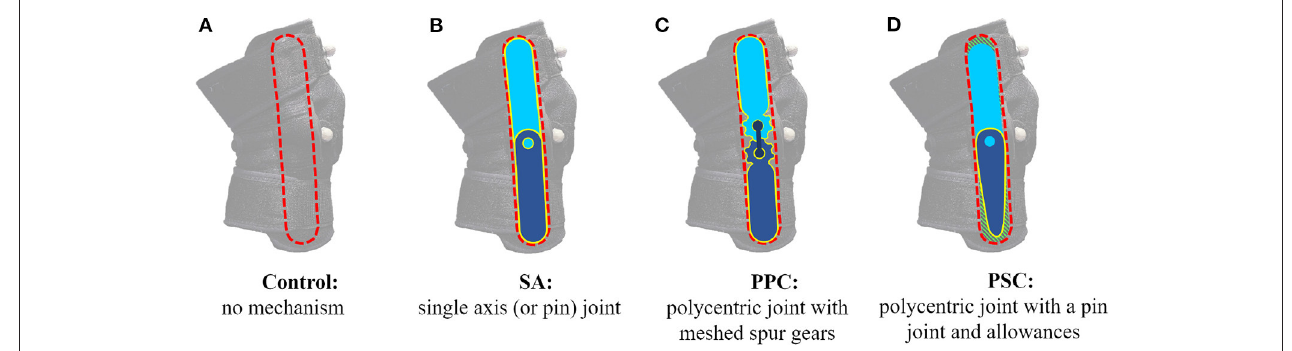
FIGURE 1 | Knee brace mechanisms: (A) Control brace with no mechanism, (B) single axis (SA) brace with a single axis mechanism, (C) polycentric mechanism with a predefined centrode (PPC) brace with a polycentric mechanism having spur gears, and (D) polycentric mechanism with a self-aligning center of rotation (PSC) brace with a polycentric mechanism with allowances.